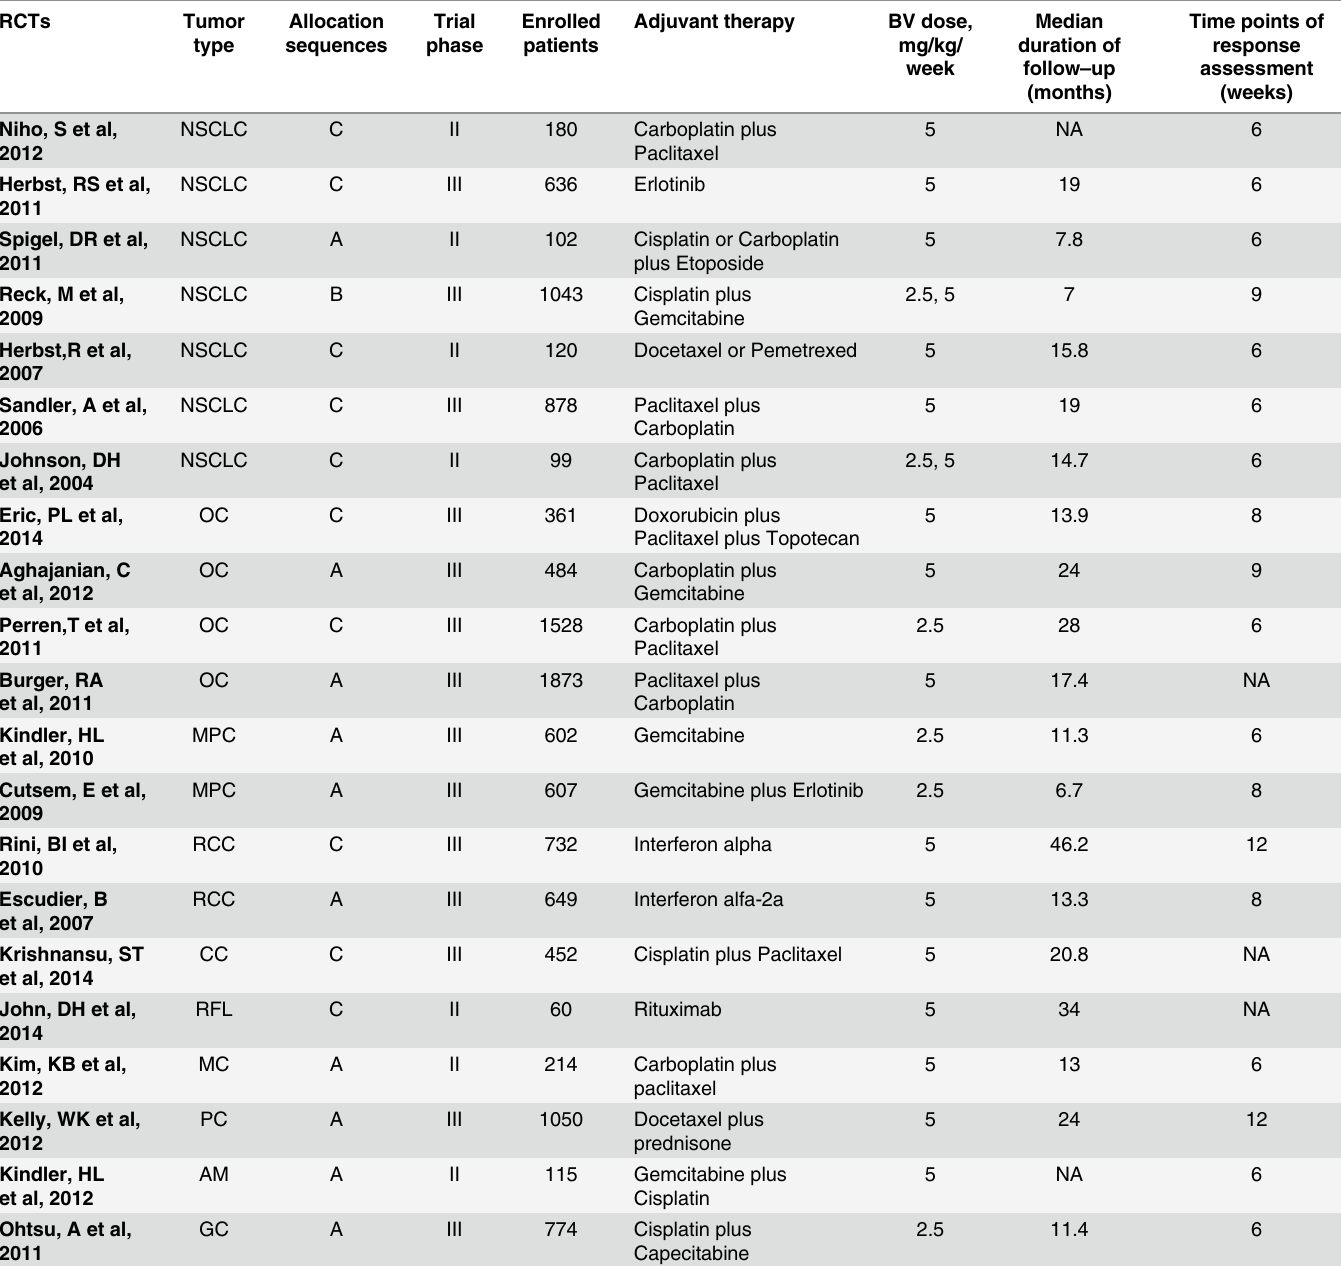
I 2 :72.4%, random-effects model) ( Fig 2 ) with high heterogeneity attributed to the colorectal cancer (I 2 : 82.3%) and ovarian cancer (I 2 : 92.8%) trials. PFS statistically significantly